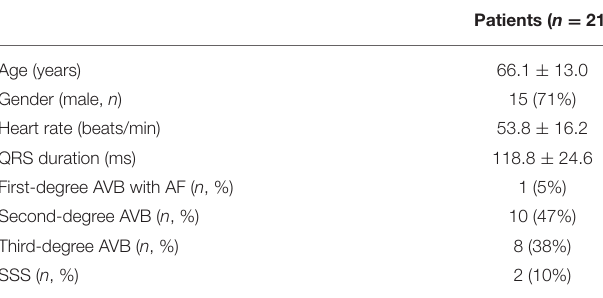
TABLE 1 | Baseline characteristics of patients.